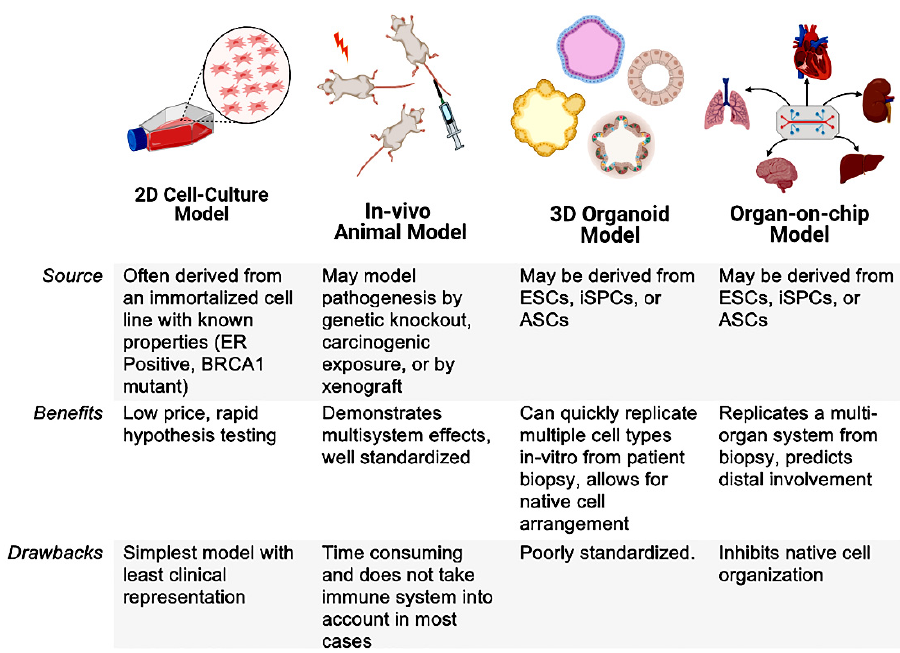
Figure 2. The range of models currently available in oncology with inherent drawbacks or advantages for desired research